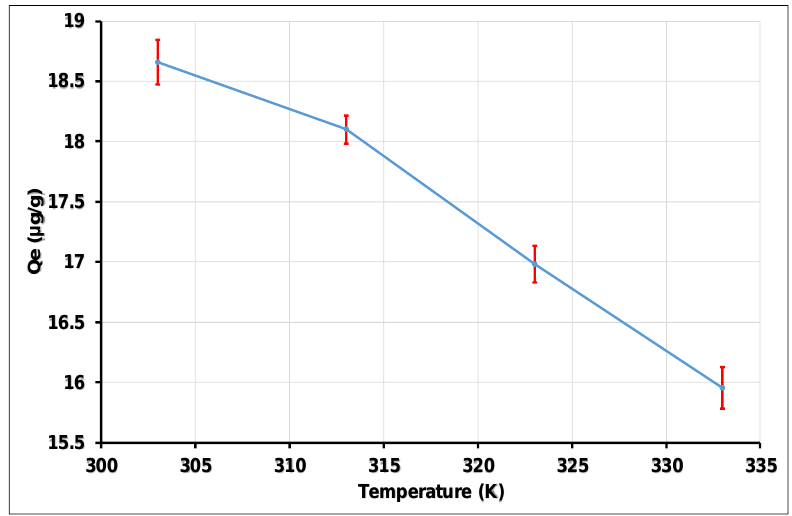
Figure 16. Effect of temperature.